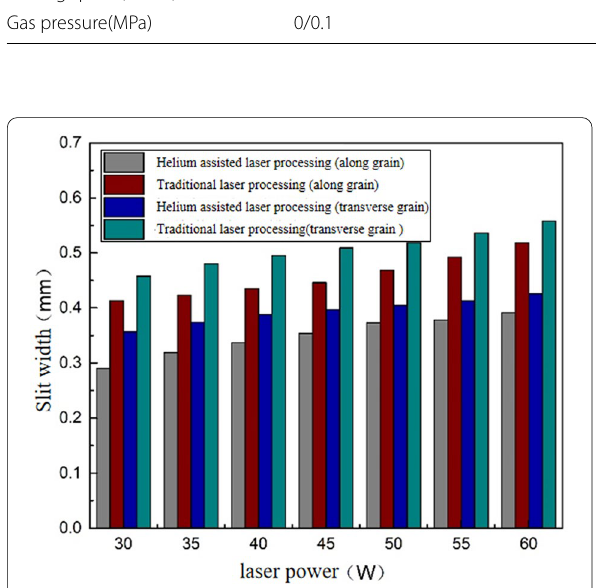
Fig. 8 Influence of laser parameters on the width of kerf during grain cutting